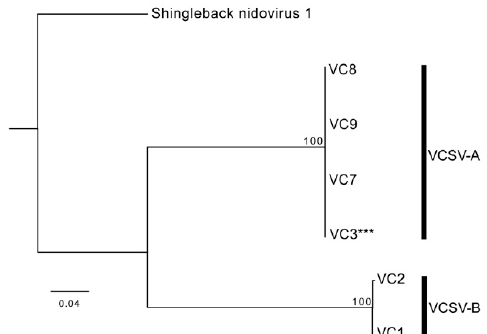
Figure 4. Phylogenetic tree of veiled chameleon serpentoviruses (VCSV). Sequences of PCR amplicons